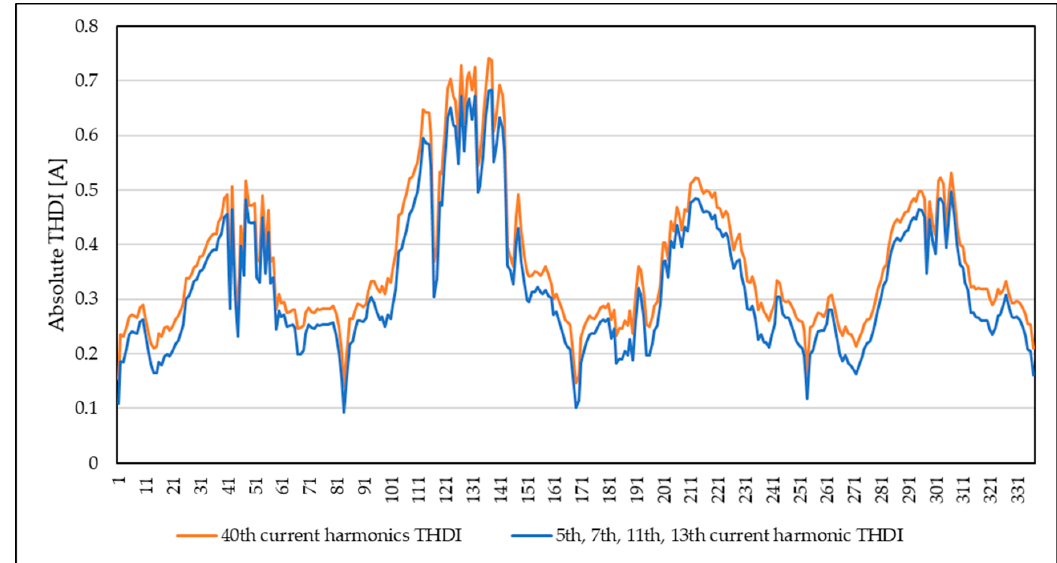
Figure 7. The absolute THDI calculated from the 2nd to the 40th current harmonics and the absolute THDI calculated from 5th, 7th, 11th, and 13th current harmonic.